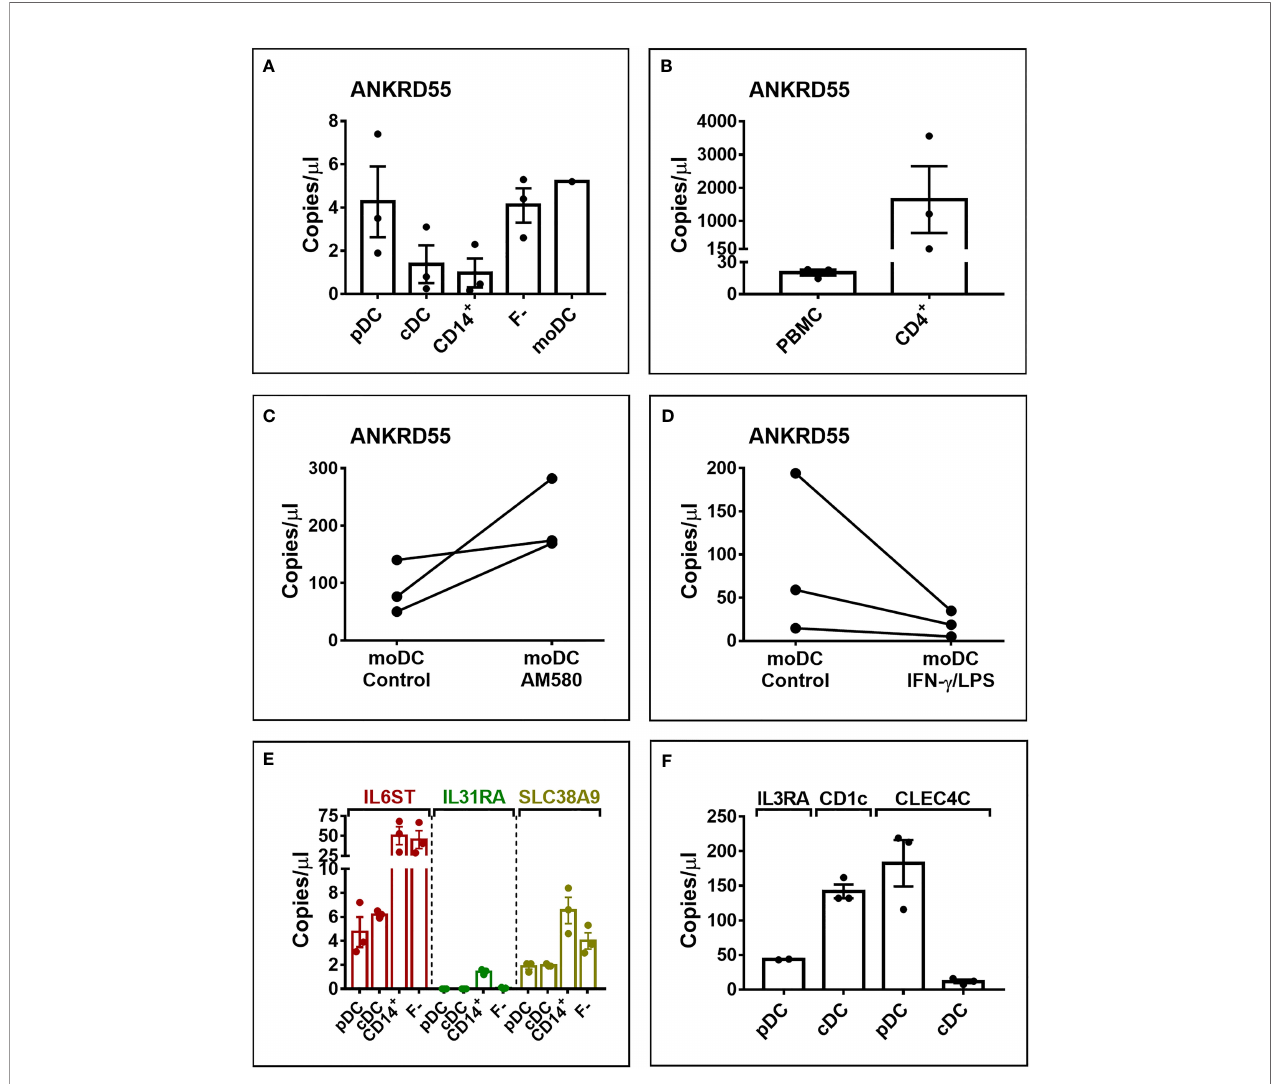
FIGURE 5 | Digital droplet PCR (ddPCR) quanti fi cation of gene transcript copy numbers in pDC, mDC, CD14 + monocytes, PBMC fraction minus monocytes (F-), and moDC. Analysis was performed in 350 pg cDNA (A, E, F) or 30 ng of cDNA (B – D) . (C) ddPCR quanti fi cation of ANKRD55 transcript copy numbers in moDC treated with AM-580. (D) ANKRD55 copy numbers in moDC matured or not with IFN- g /LPS measured at 6 h after addition of stimulus. (F) Transcript levels of markers speci fi c for mDC (CD1c) and pDC (IL3RA,